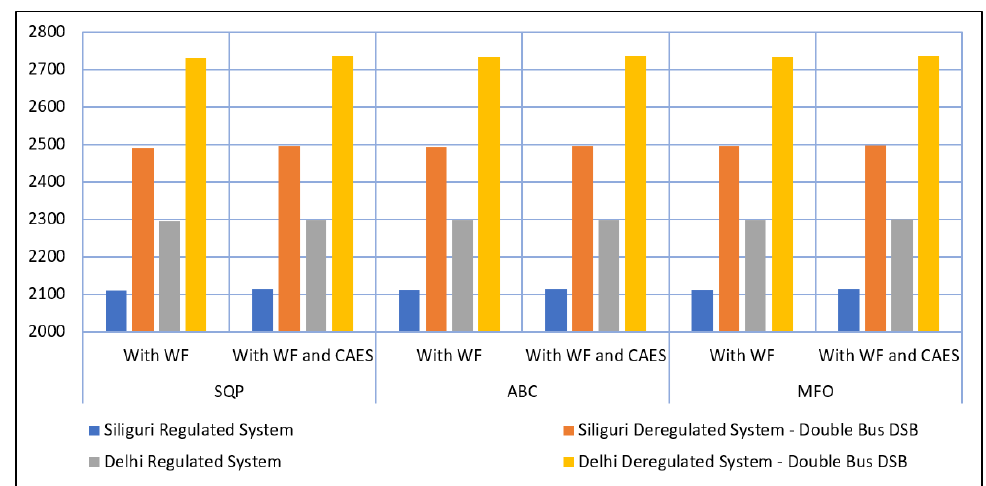
Figure 12. Average hourly profit with different optimization techniques for Siliguri and Delhi.